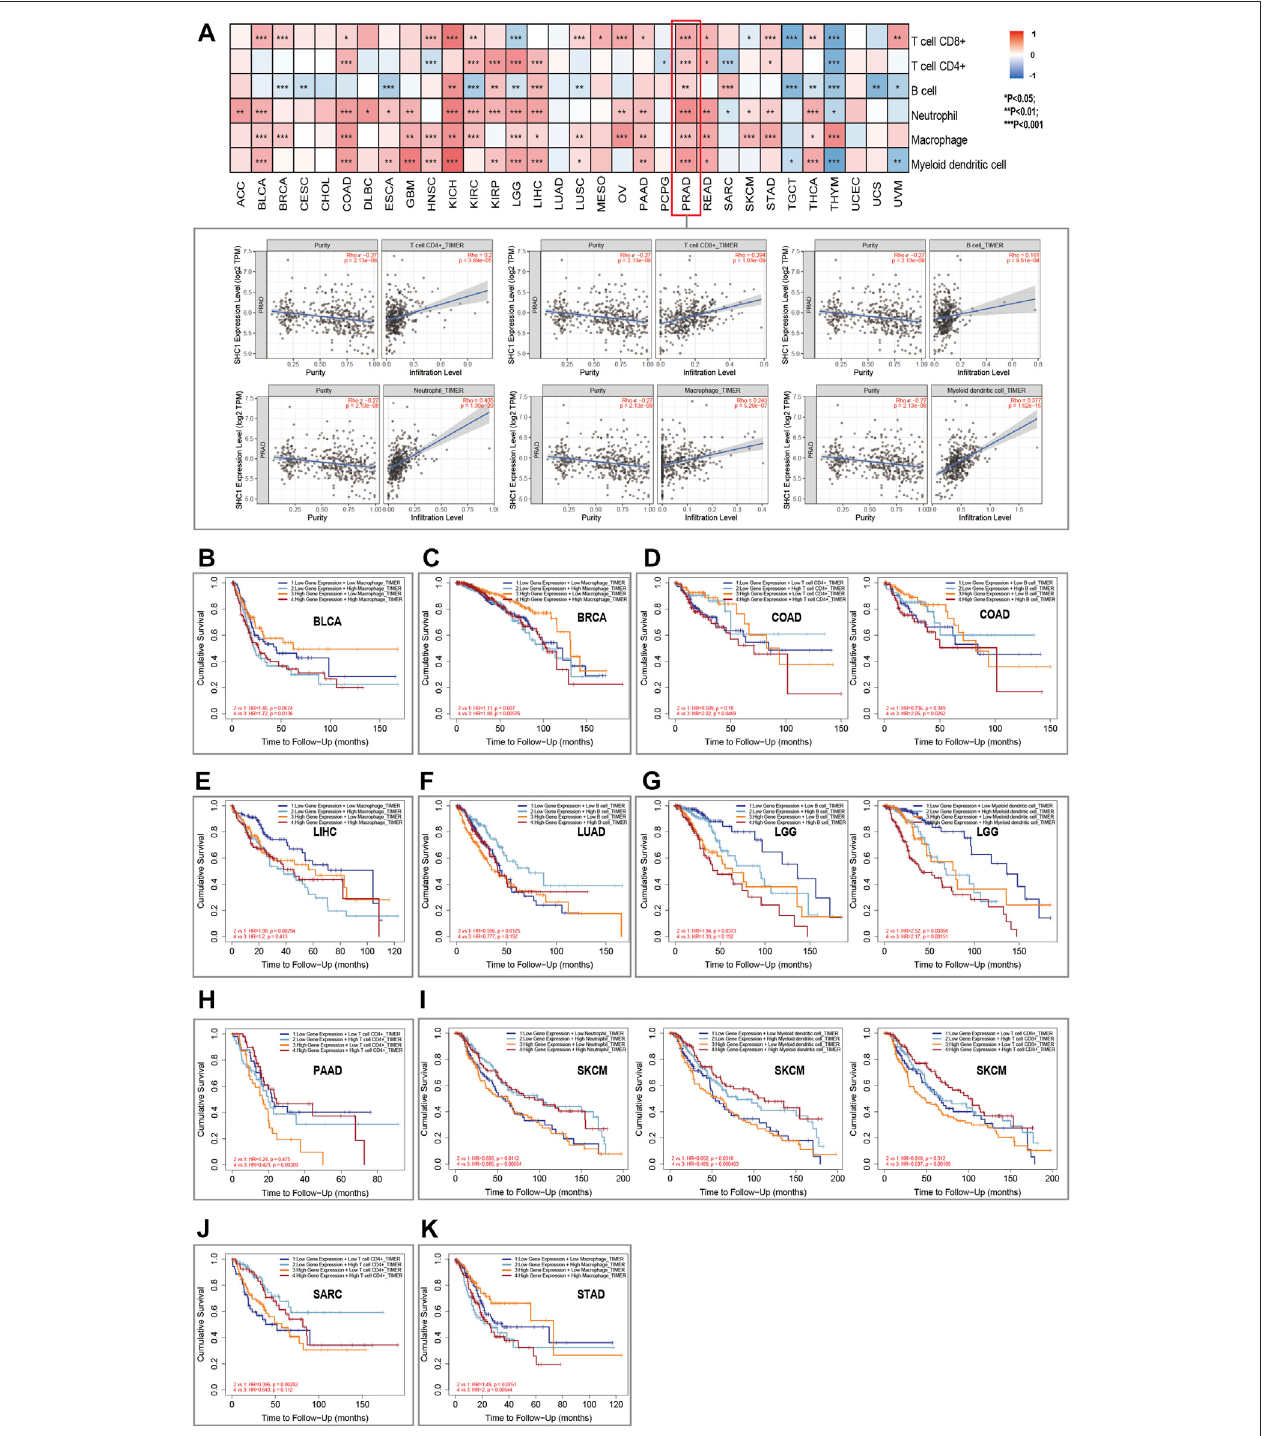
FIGURE 7| Relationship between SHC1 expression and immune in fi ltration in various tumors. (A) Correlation ofSHC1 expression with immunein fi ltration levels of CD4 + Tcells,CD8 + Tcells,Bcells,neutrophilcells, macrophagecells,and myeloiddendriticcells.SurvivalanalysisofSHC1expression levelandMacrophagein fi ltration level in BLCA (B) , BRCA (C) . Survival analysis of SHC1 expression level and in fi ltration levels of CD4 + T cell or B cell in COAD (D) . Survival analysis of SHC1 expression level and Macrophage in fi ltration level in LIHC (E) . Survival analysis of SHC1 expression level and B cell in fi ltration level in LUAD (F) . Survival analysis of SHC1 expression level and in fi ltration levels of B cell and myeloid dendritic cell in LGG (G) . Survival analysis of SHC1 expression level and CD4 + T in fi ltration level in PAAD (H) . Survival analysis of SHC1 expression level and in fi ltration levels of Neutrophil, myeloid dendritic cell, and CD8 + T cell in SKCM (I) . Survival analysis of SHC1 expression level and CD4 + T cell in fi ltration level in SARC (J) . Survival analysis of SHC1 expression level and Macrophage in fi ltration level in STAD (K) . p < 0.05 was considered statistically signi fi cant.